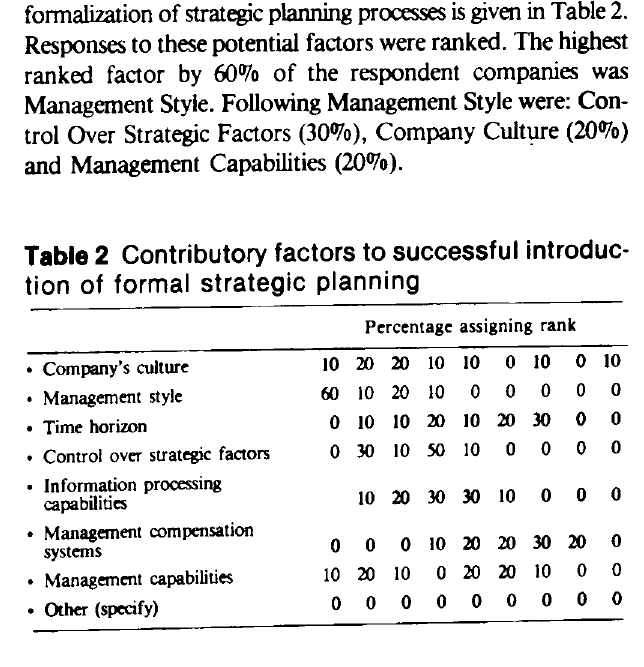
Table 2 Contributory factors to successful